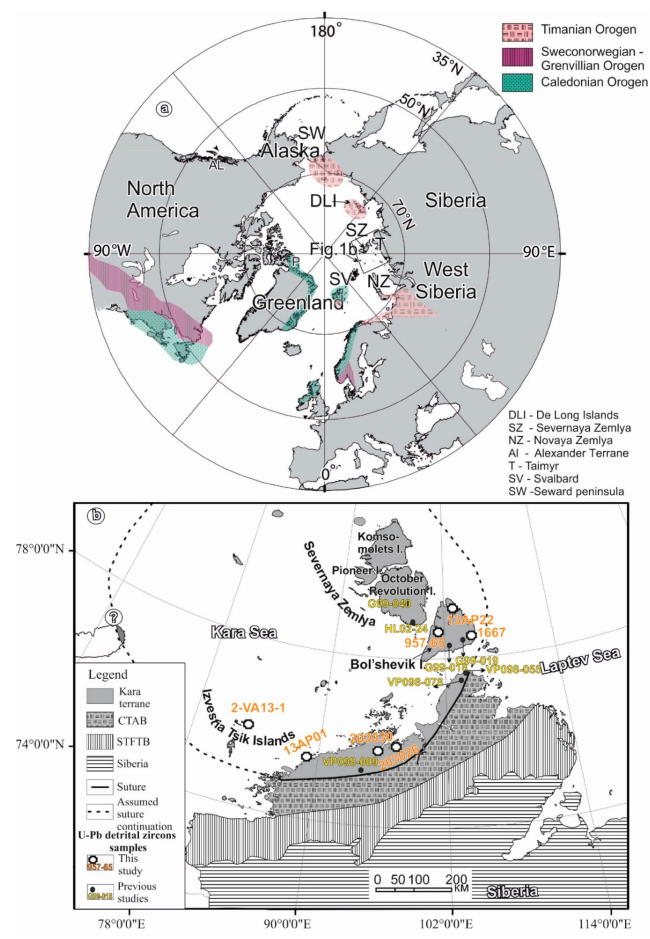
Figure 1. ( a ) Regional setting of the study area; ( b ) Simplified geological map of Kara Terrane (from [13,20]) with locations of the studied samples. In addition, the locations of the samples from [1,19] are